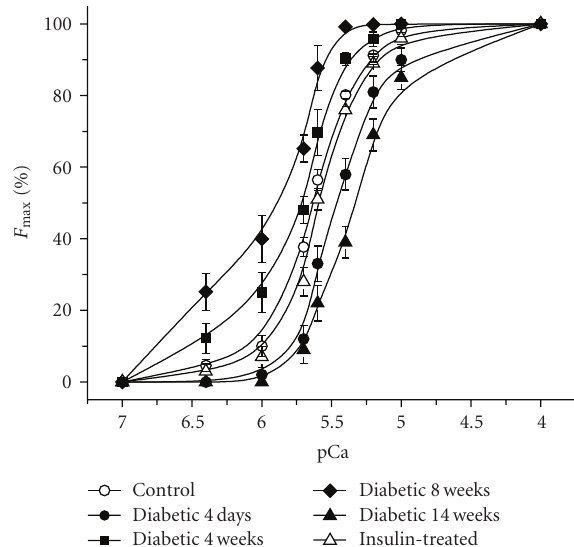
Figure 3: Diabetes alters the essential contractile properties in Triton-skinned muscle fibers. All data are presented as the mean ± SD. Force-versus-pCa relationships for all conditions are shown. The open circle symbol shows the average control force-versus-pCa curve, closed circles show 3-4 days diabetic, closed squares 4 weeks diabetic, closed diamonds 8 weeks diabetic, closed triangles 14 weeks diabetic, and open triangles the insulin-treated muscle fibers. F max , number of experiments and statistical details are presented in Table 1 and methods.